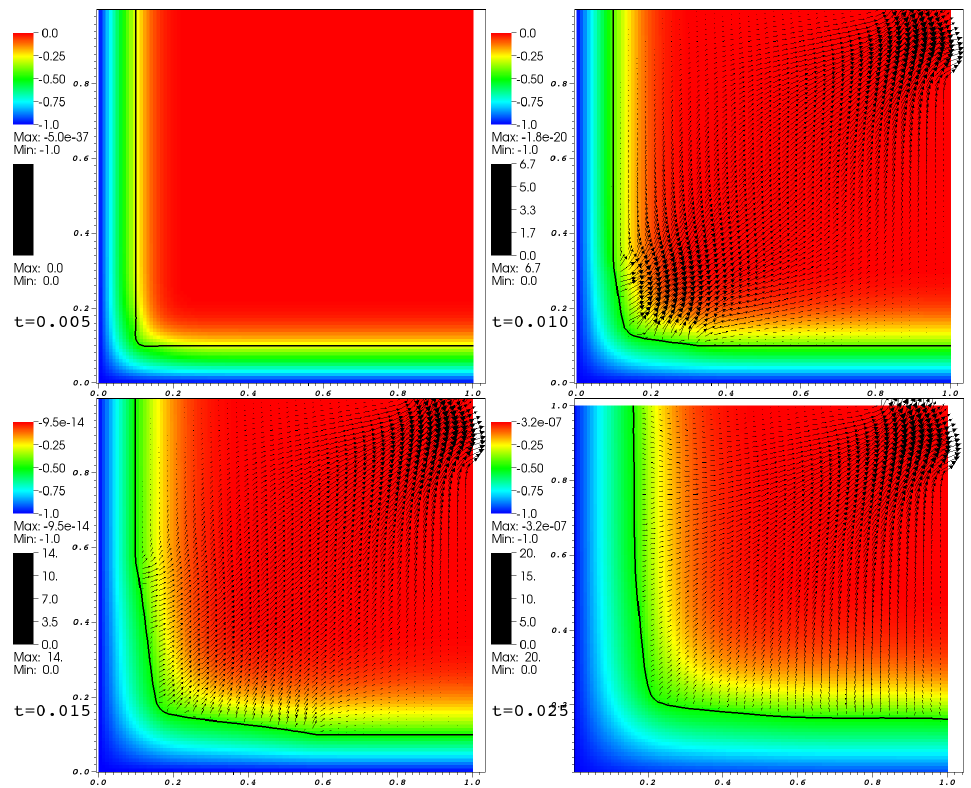
Figure 8. Two-dimensional corner Stefan-like test case—Mesh size: 110 × 110 cells, ∆ t = 10 − 4 . Initial temperatures T 0 = 0, external temperature T ext = − 1—Temperature fields in colors, interface in black line and velocity field with black arrows—( Top left ): time t = 0.005, no phase change and no motion (pure conduction)—( Top right ): time t = 0.01, solidification at the corner implying a volume change and therefore a non-zero velocity field—( Bottom left ): time t = 0.015, solidification propagates along the interface while far away pure conduction still occurs—( Bottom right ): time t = 0.025, the whole interface is